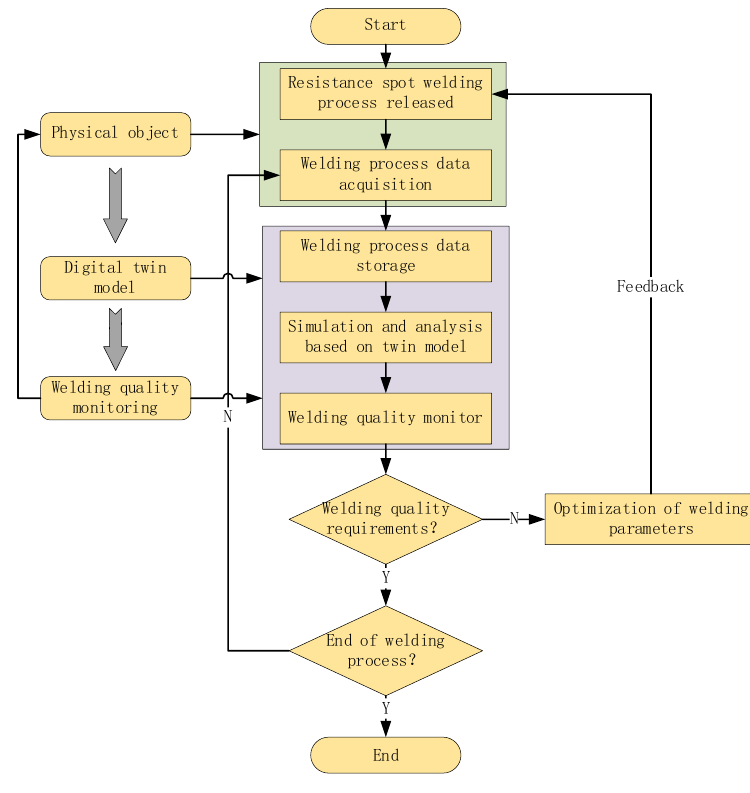
Figure 2. System